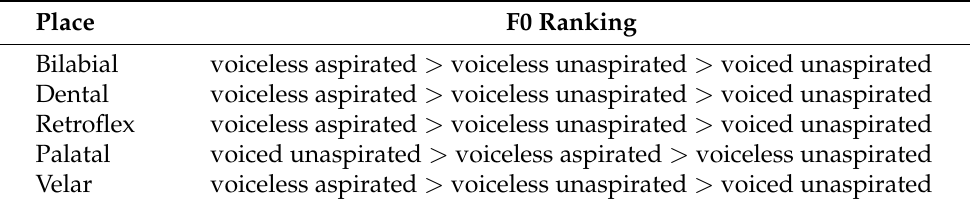
Table 1. F0 ranking of the three laryngeal categories at each place of articulation. Place F0 Ranking Bilabial voiceless aspirated > voiceless unaspirated > voiced unaspirated Dental voiceless aspirated > voiceless unaspirated > voiced unaspirated Retroflex voiceless aspirated > voiceless unaspirated > voiced unaspirated Palatal voiced unaspirated > voiceless aspirated > voiceless unaspirated Velar voiceless aspirated > voiceless unaspirated > voiced unaspirated Spectral tilt/balance measures are generally higher (steeper) for breathier phonations and lower (shallower or negative) for creakier phonations (see discussion above). Figure 4 presents violin plots of H1*-H2*, H1*-A1*, H1*-A2*, and H1*-A3*. Table 2 shows results of the LMER models. H1*-H2* differentiated the voiced unaspirated vs. voiceless unaspirated stops ( p < 0.001) and bilabials vs. palatals ( p = 0.001), bilabials vs. retroflexes ( p = 0.002), and bilabials vs. velars ( p = 0.002). H1*-H2* onset was higher in the voiceless aspirated than voiceless unaspirated and voiced unaspirated stops (voiceless aspirated > voiceless unaspirated > voiced unaspirated).